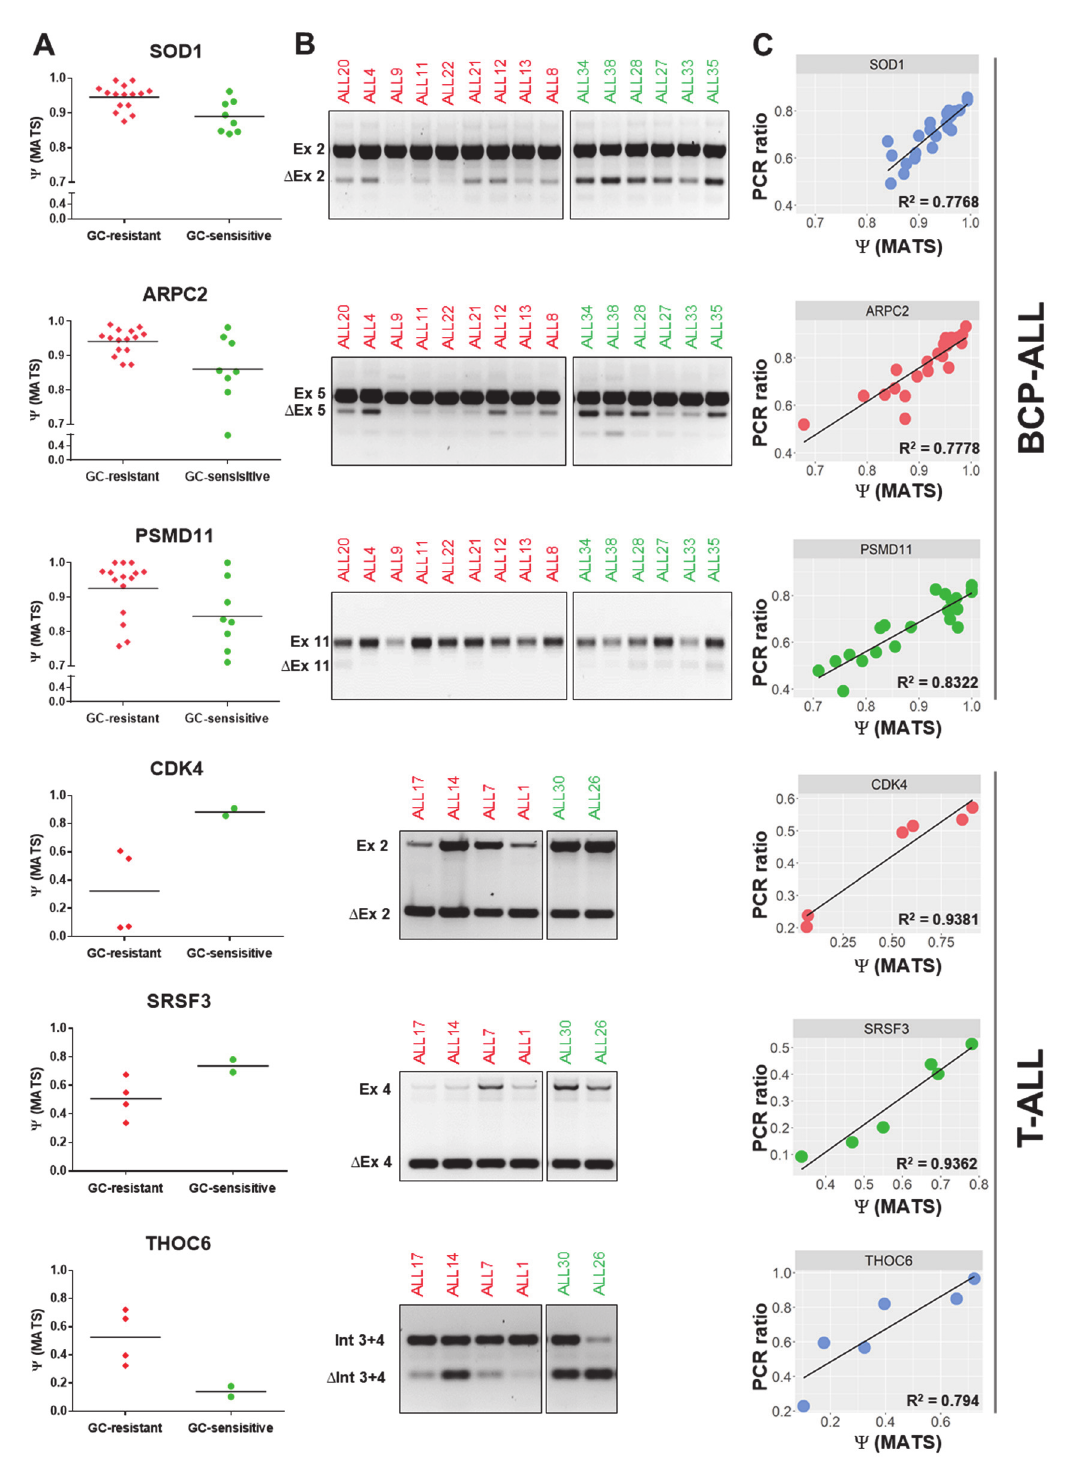
Figure 4. PCR validations of di ff erential splicing events predicted by the rMATS algorithm. The PCR validations were performed for 13 di ff erential splicing events identified in BCP-ALL and 19 di ff erential splicing events identified in T-ALL (Figure A1). The figure depicts 3 selected genes per each subtype, including splicing regulators and GC resistance-related genes. ( A ) Ψ values generated by rMATS in GC-resistant and GC-sensitive samples (FDR < 0.05). ( B ) Electrophoresis gels illustrating the results of PCR validations for selected di ff erential splicing events identified by rMATS. ( C ) Association between rMATS-calculated and PCR-derived Ψ values (PCR ratio) was evaluated per each validated event using the linear regression model. Ex: exon inclusion; ∆ Ex: exon skipping; Int: retained intron; ∆ Int : intron